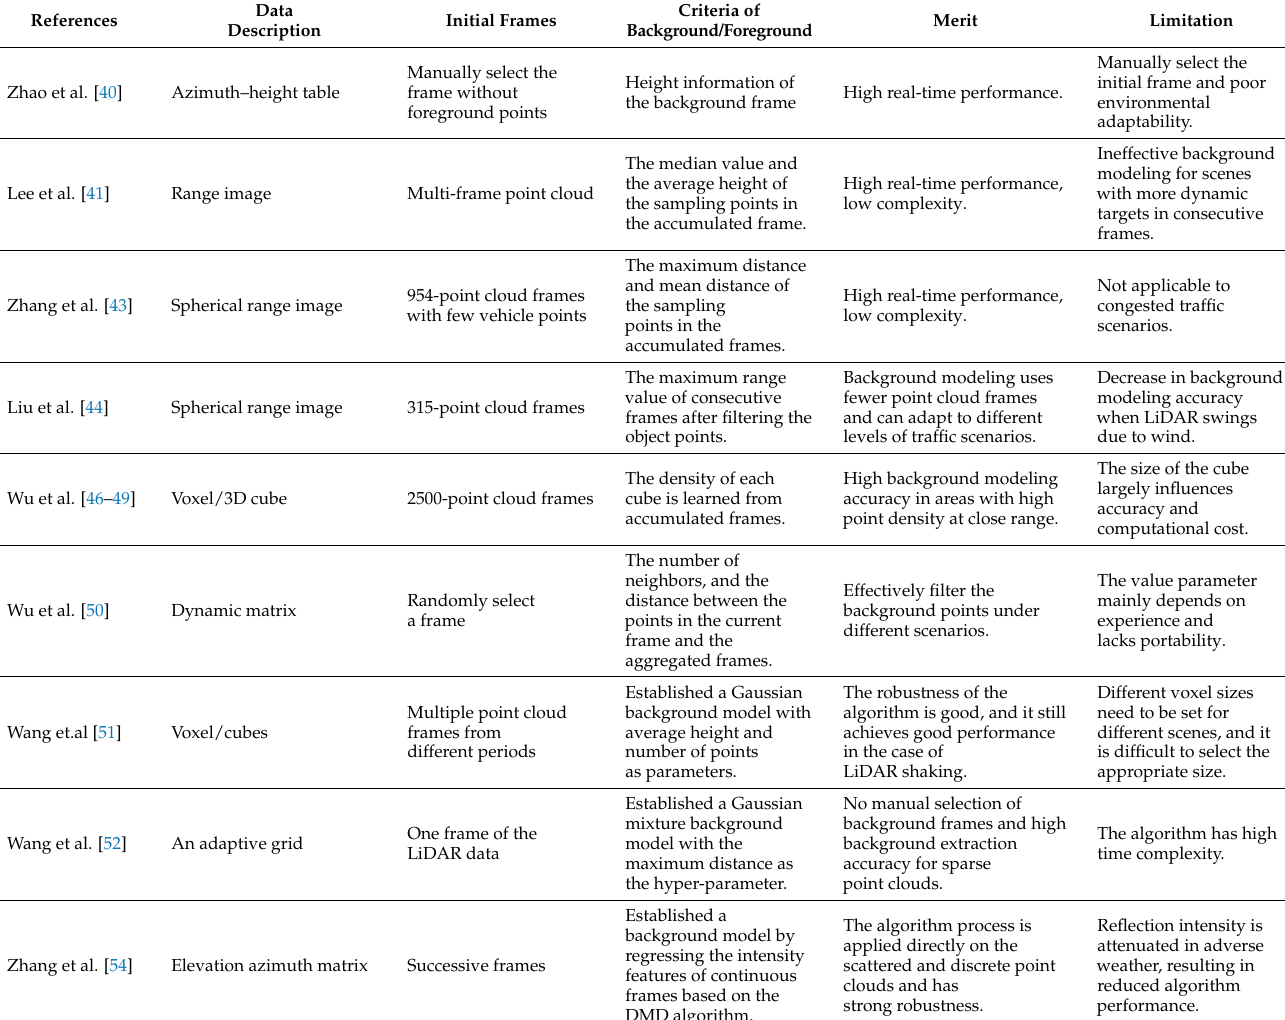
Table 2. Summary of background modeling for roadside